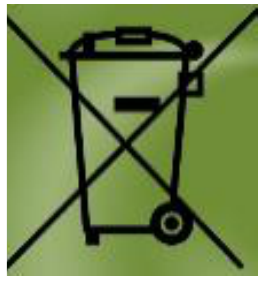
Figure 4. E-waste pictogram.